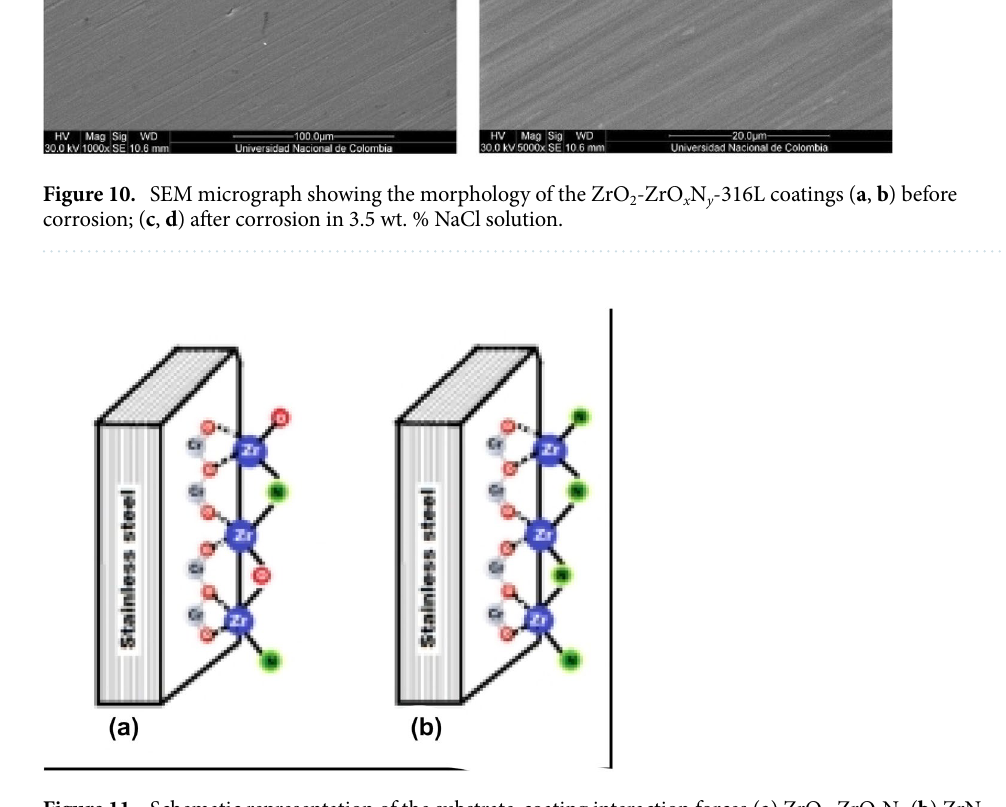
Figure 11. Schematic representation of the substrate-coating interaction forces ( a ) ZrO 2 -ZrO x N y ( b ) ZrN- ZrO x N y